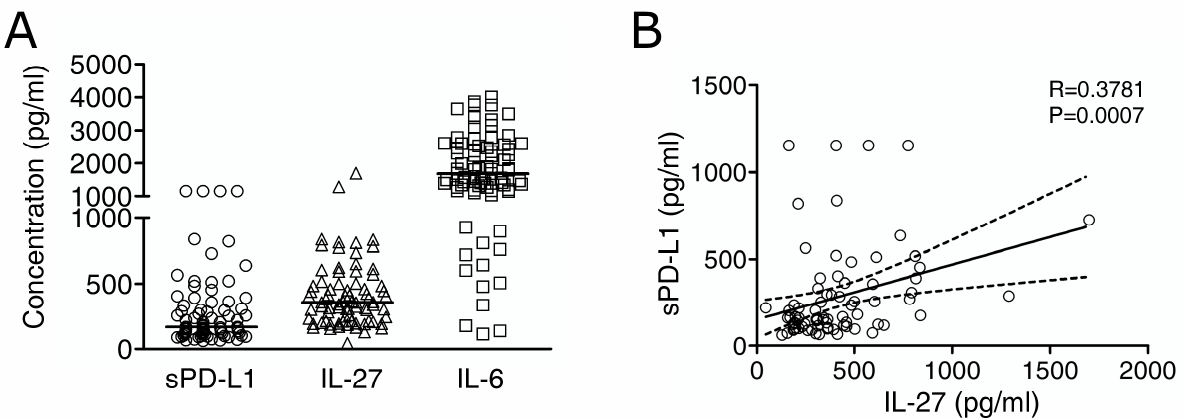
Figure 3. IL-27 is detectable in MM pleural exudates and correlates with sPD-L1 expression. ( A ) Concentration (pg/mL) of sPD-L1, IL-27, and IL-6 in pleural effusion. Bars indicate median values. ( B ) Correlation between IL-27 and sPD-L1 levels in MM pleural fluids. Spearman’s rank correlation coefficient (R) and p -value (P) are indicated. Lines represent the best fit linear regression analysis with the 95% confidence interval.